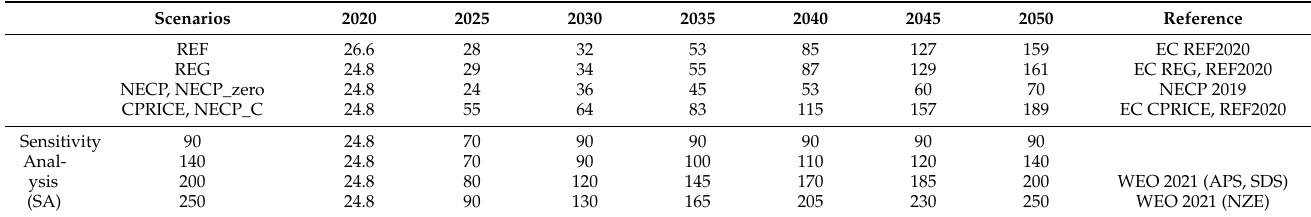
Table 4. EUA emission allowance price (EUR 2020/t CO 2 ).